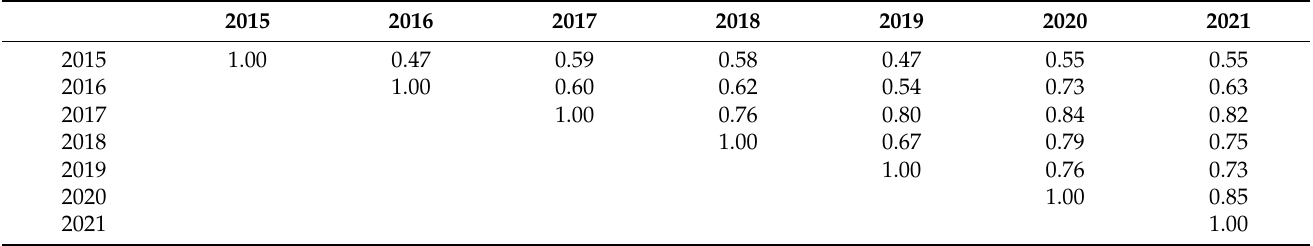
Table 5. A correlation among the spatial distribution of boats.